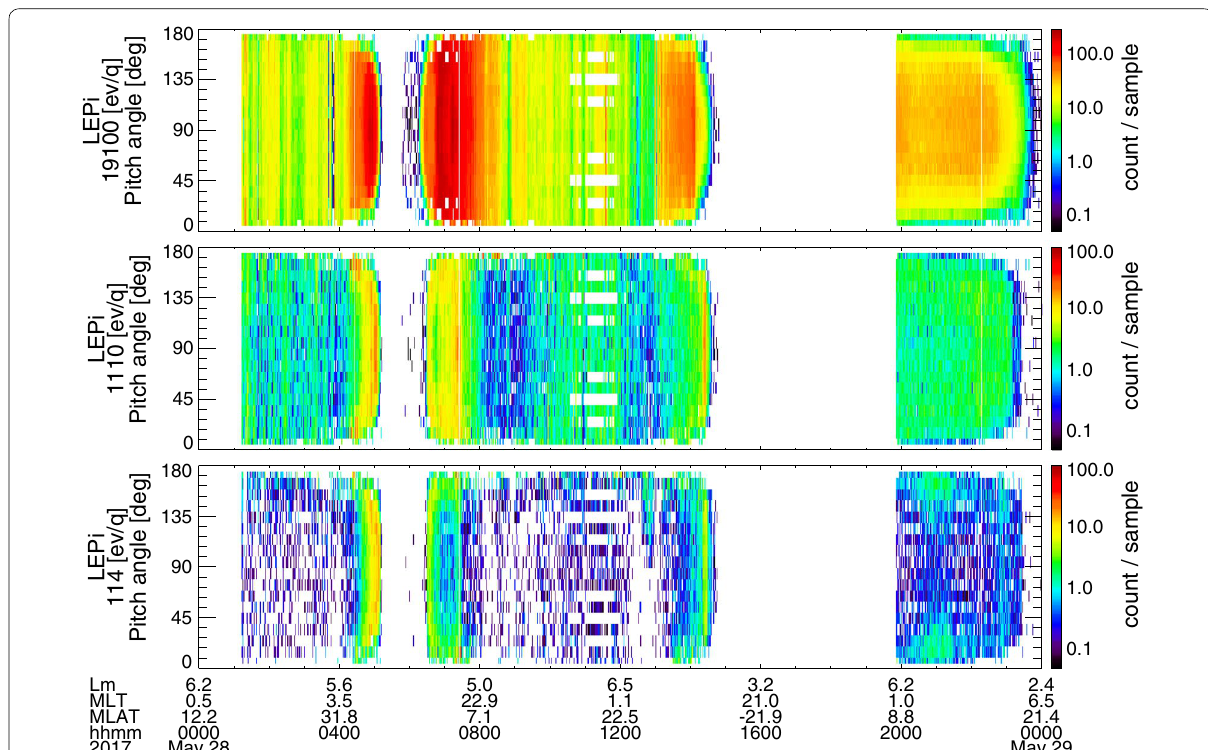
Fig. 16 Pitch angle–time plot for the protons with energies of 19,200, 1110, and 114 eV. Time period of the plot is the same as that of Fig. 15